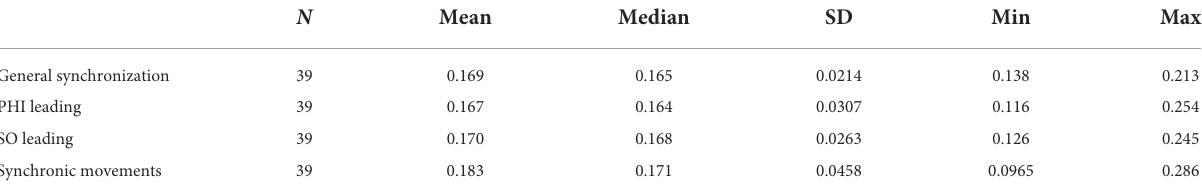
TABLE 1 Results of MEA (motion energy analysis).